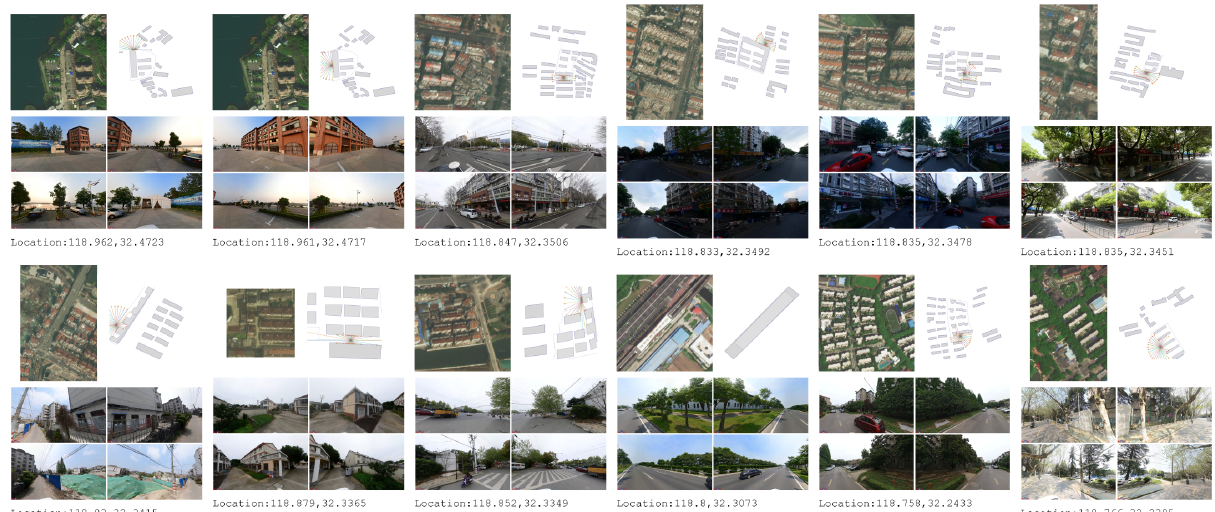
Figure 3. Examples of the samples in the dataset, include satellite images, master plans, and SVIs.